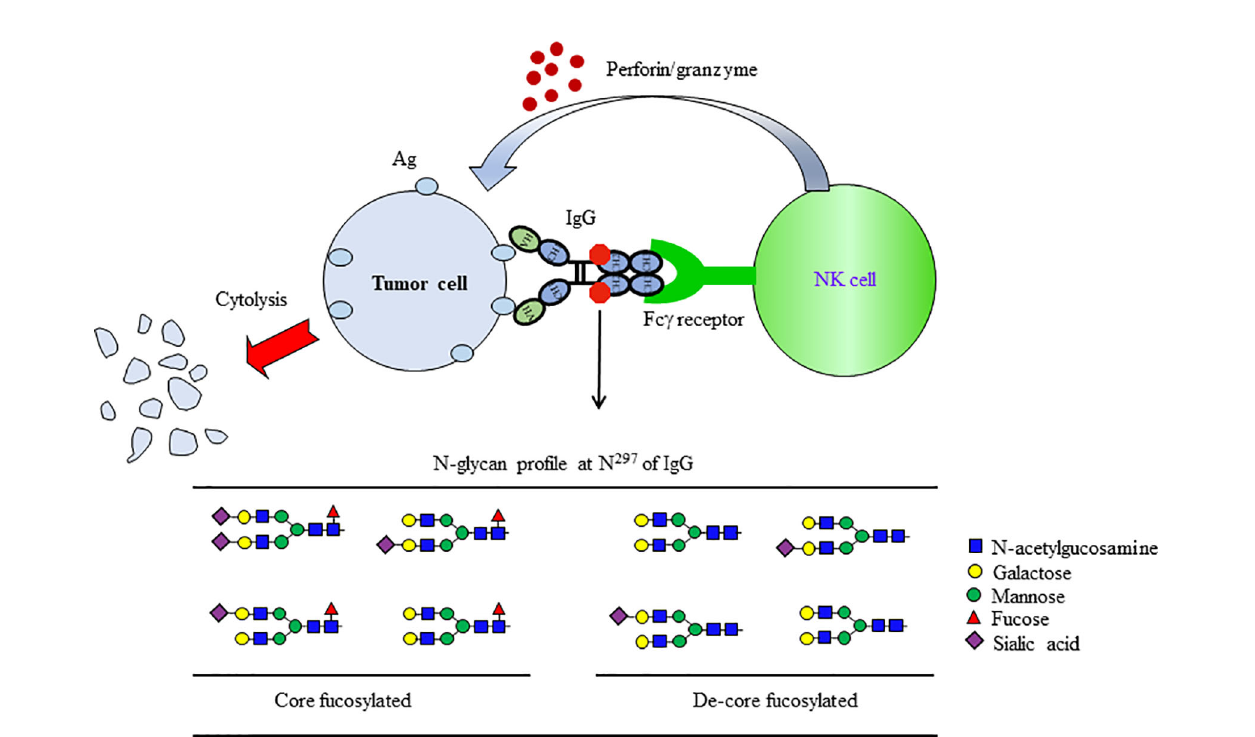
FIGURE 5 | De-fucosylated IgG-Fc domain enhanced the induction of ADCC. ADCC is a speci fi c effector mechanism of natural killer (NK) cells. ADCC refers to the killing of a target cell, which is coated with Abs by NK cells of the immune system. When the antibodies bind to the target Ag (tumor Ag), the IgG Fc is recognized by NK cells via Fc g Rs on their surfaces. Following recognition, the NK cells release chemicals, which then lyse and kill the target cell bound to the Ab. The removal of core fucosylation at Asn 297 on IgG 1 results in a 50~100-fold enhancement of